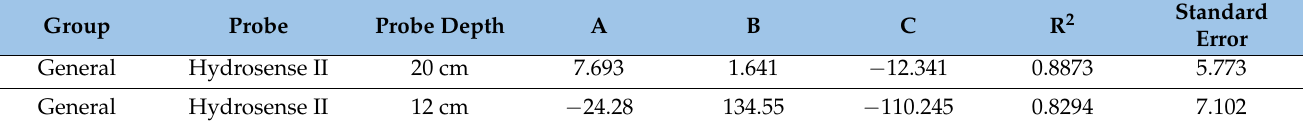
Figure A4. Boxplots of the VWC at 6 cm binned by the most predictive feature (NDVI @ 240 m) showing a peak at ~0.5 and a local minima at ~0.8. Table A1. Coefficients used to calibrate in situ and SAR-derived volumetric water contents for general Alaskan soil types [49].